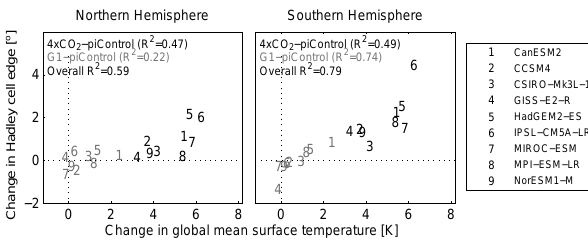
Figure 8. As in Fig. 7 but for the change in the Hadley cell edge latitude versus the change in global-mean surface temperature in the Northern Hemisphere and in the Southern